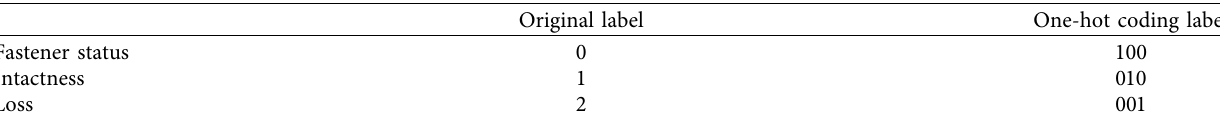
Table 4: Label coding.